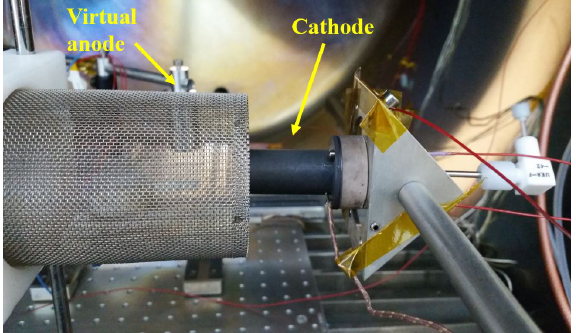
Figure 11. Experimental setup for the characterization tests of the coaxial hollow cathode.